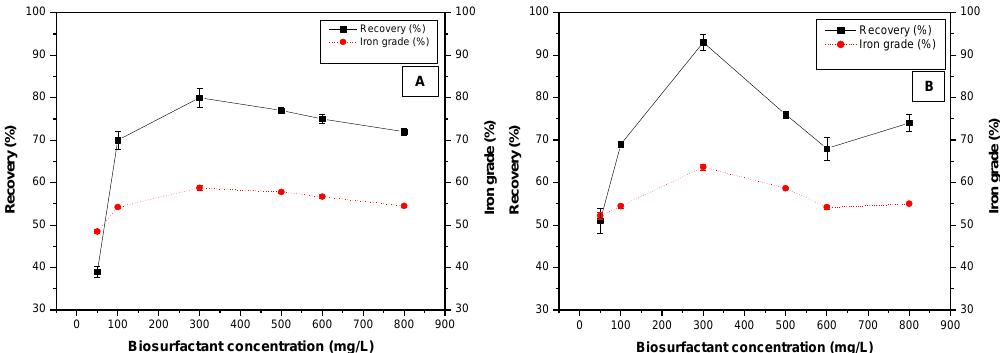
Figure 10. Electroflotation of iron ore as a function of biosurfactant concentration. Current density 16 mA/cm 2 , pH 3, agitation 300 rpm. ( A ): Particle size: − 38 + 20 µm. ( B ): Particle size: − 20 µm.